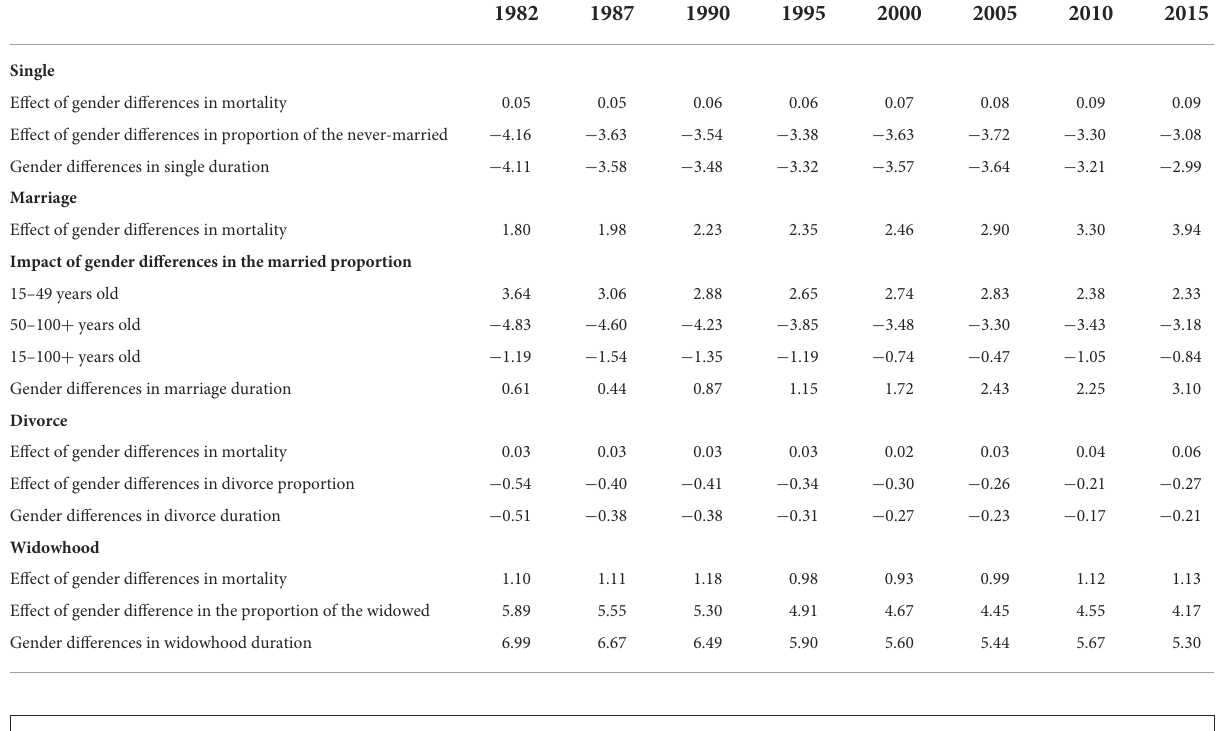
TABLE 3 Decomposition of marital duration gender differences among 15-year-olds.